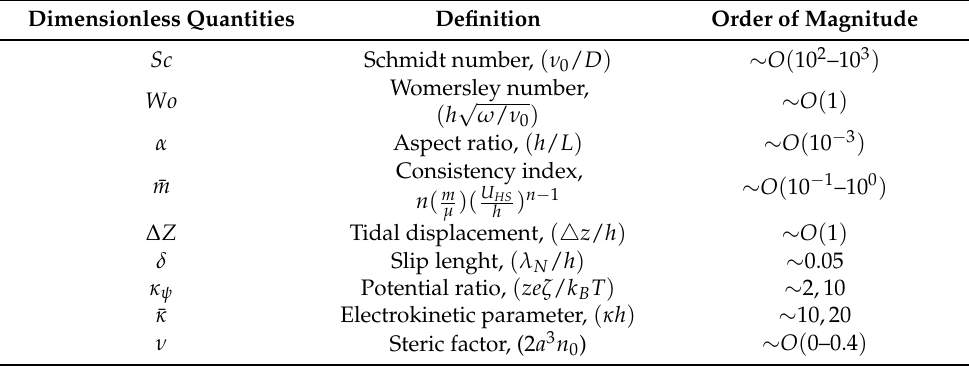
Table 1. Order of magnitude of the dimensionless quantities.